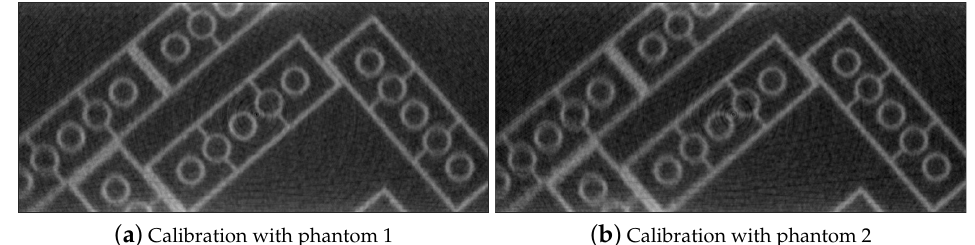
Figure 4. Reconstructions of the test phantom acquired by the 3D 2 YMOX system after stereo geometry calibration with real calibration